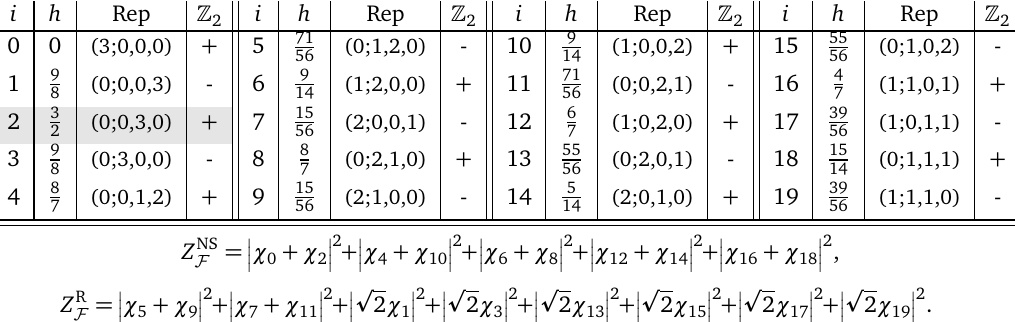
Table 8: SU ( 4 ) : primaries labeled by i are characterized by weights h and SU ( 4 ) Dynkin labels. 3 ( τ ) . We highlight the primary related to the (cid:90) Their characters are denoted by χ i center symmetry (cid:90) . The partition functions for F in the NS and R sectors are also 4